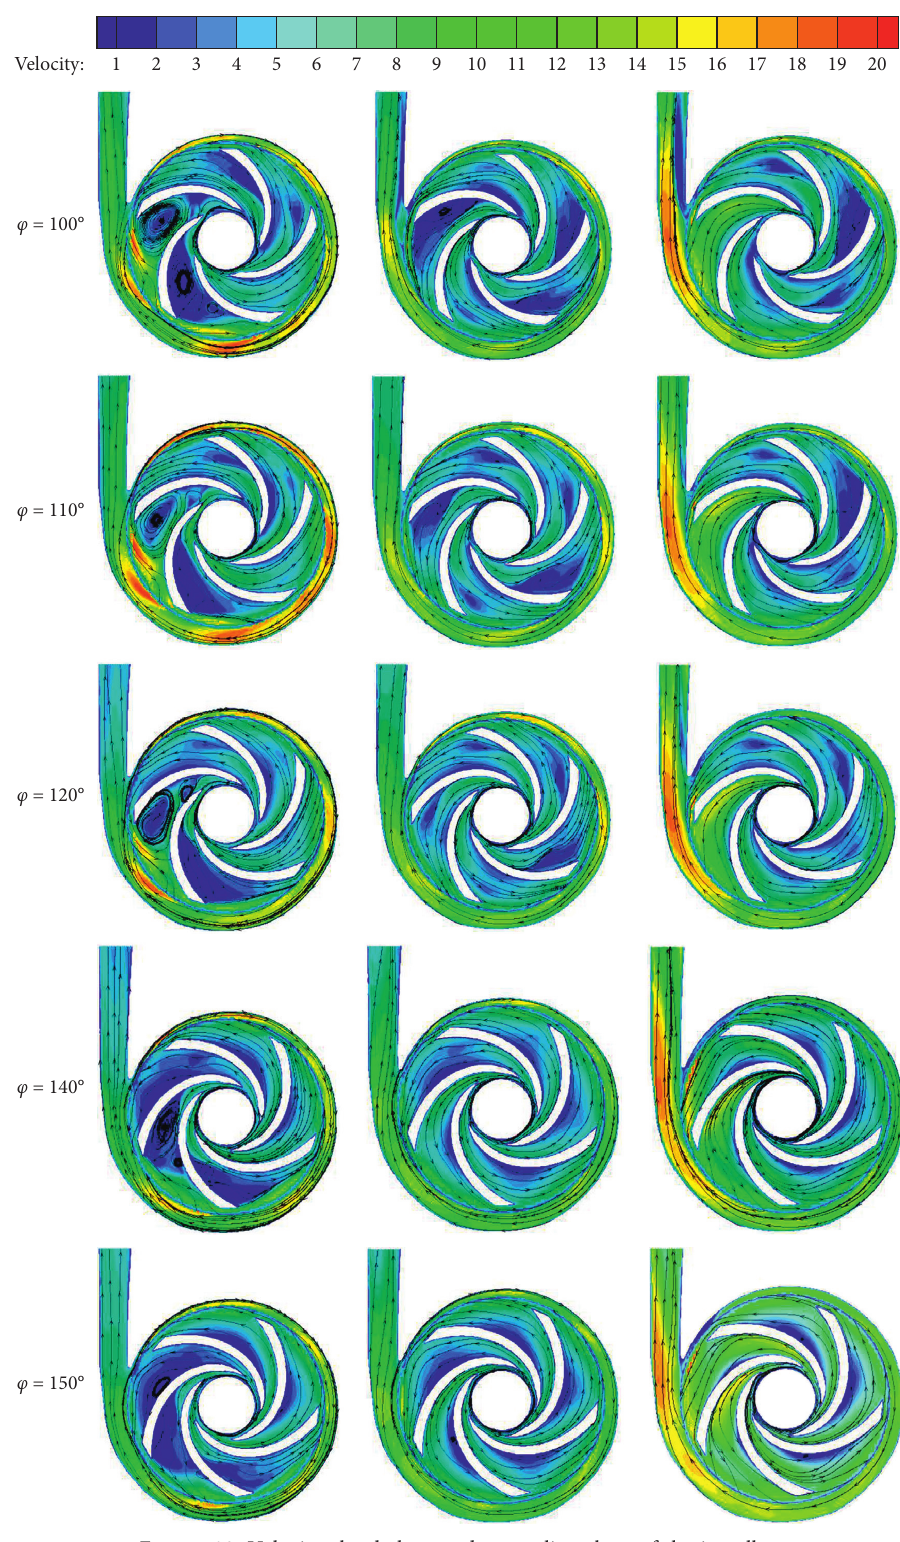
Figure 20: Velocity cloud chart and streamline chart of the